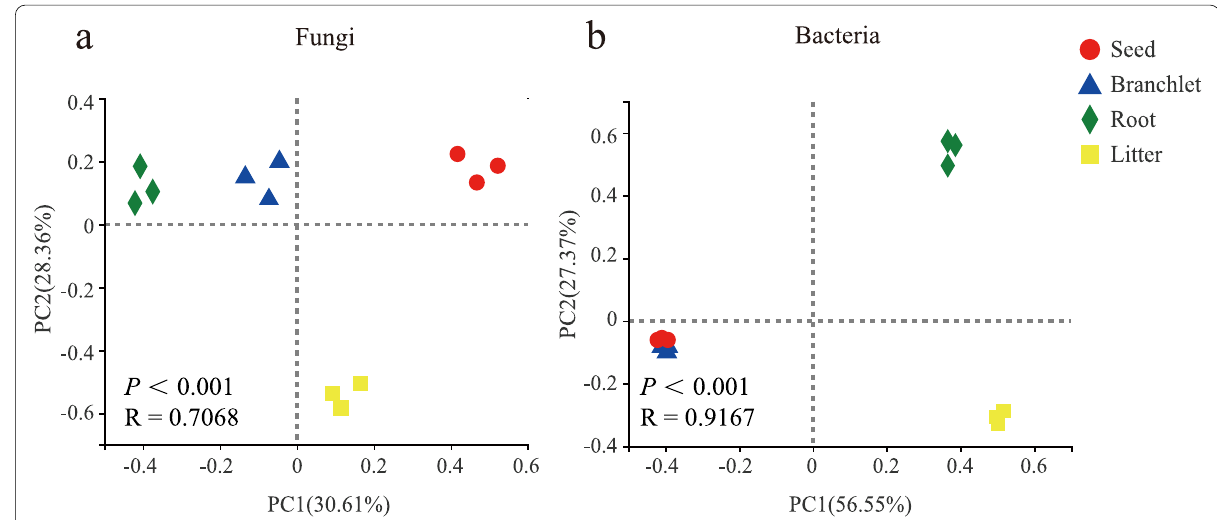
Fig. 2 PCoA of endophytic fungi (left) and bacteria (right) in seeds, branchlets, roots, and litter of C. equisetifolia. Different colors and shapes represent different samples. The distance among the points represents the similarity of the samples, and the closer they are, the more similar they are